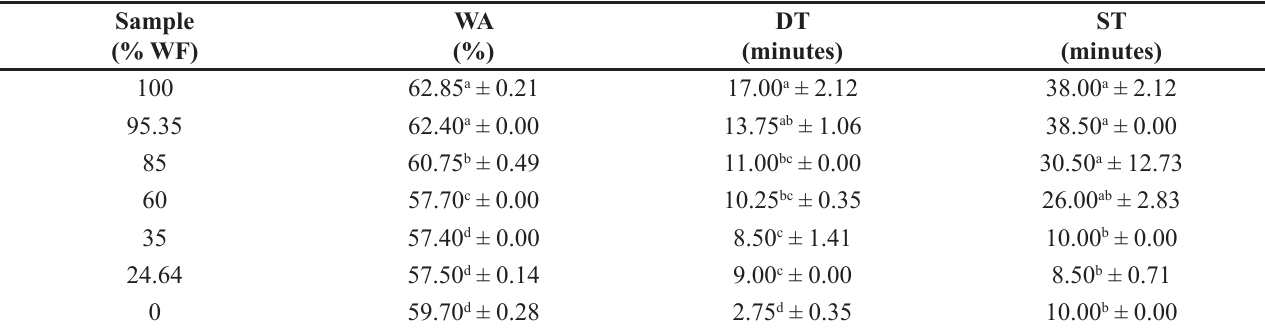
TABLE II - Farinographic characterization of flours Sample